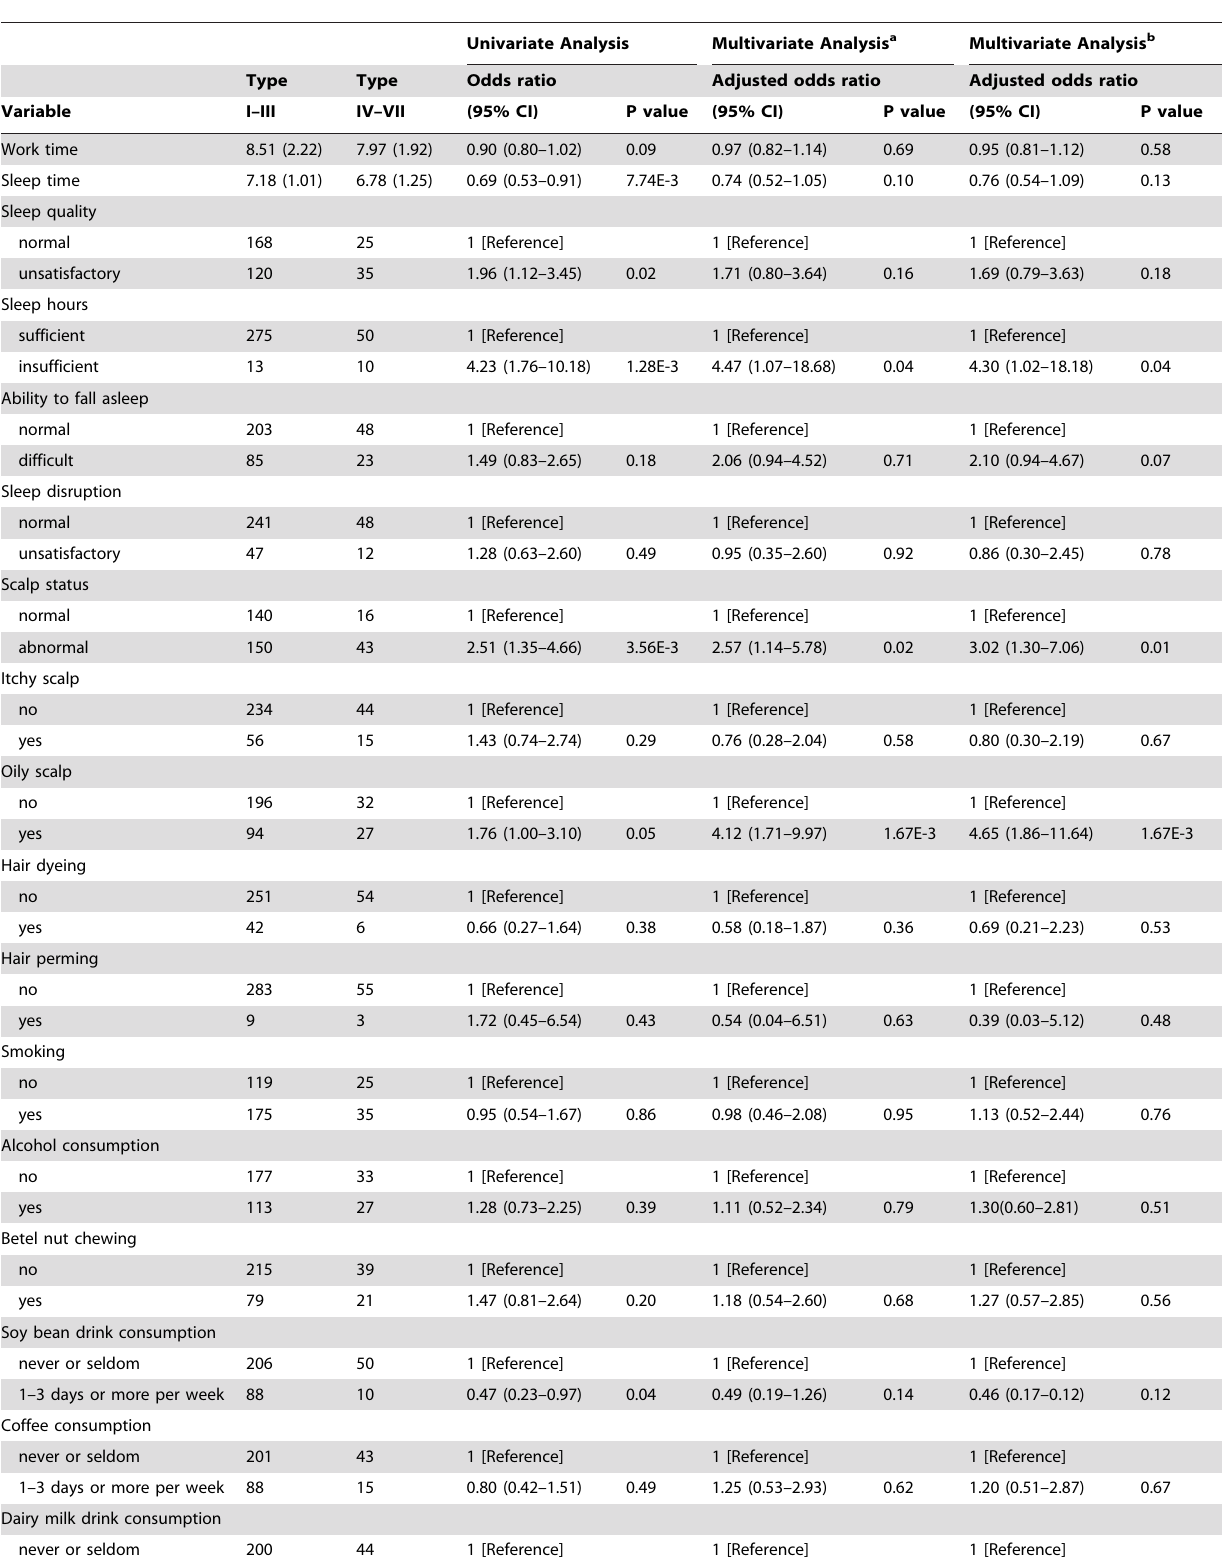
Table 3. Simple and general linear regression analyses of male androgenic alopecia subjects associated with environmental factors, personal behaviors and dietary